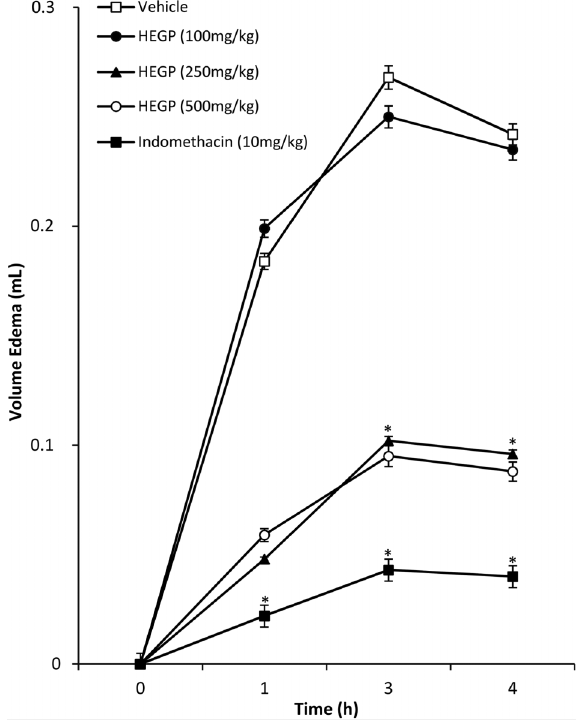
Figure 2. Effects of oral administration of the hydroethanolic extract of Gochnatia pulchra (HEGP; 100, 250, and 500 mg/kg) or indomethacin (5 mg/kg) on rat paw edema induced by intraplantar carrageenan injection (0.1 mg/paw). Data are reported as means ± SE of 6 animals. *P o 0.05, compared to the vehicle control (one-way ANOVA).